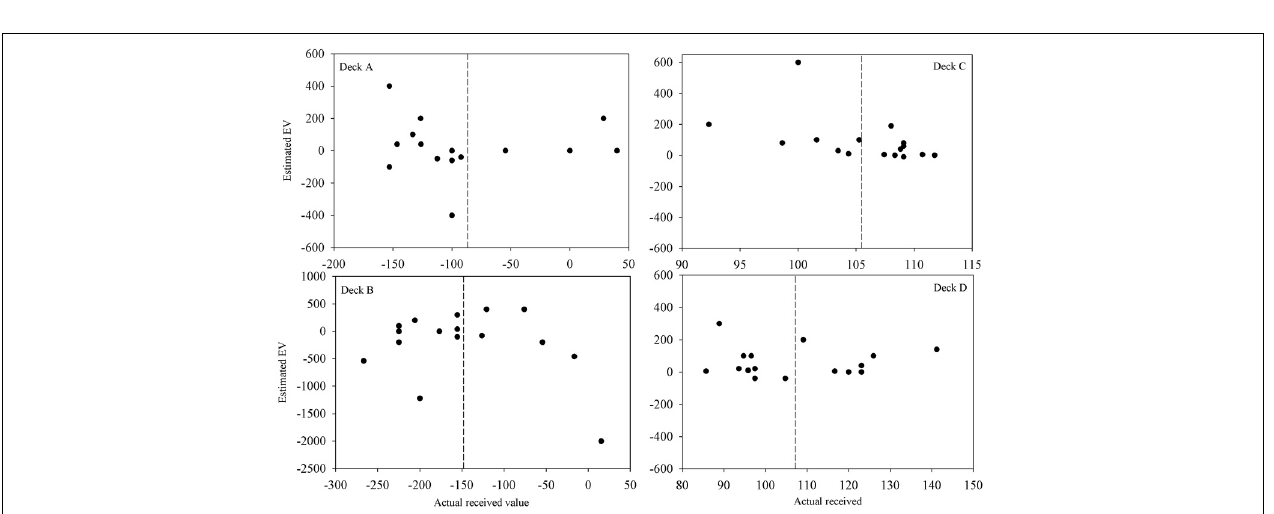
participant’s estimates of the average gain, average loss and frequency of loss over ten selections from that deck. The dashed lines are the mean actual expected values.